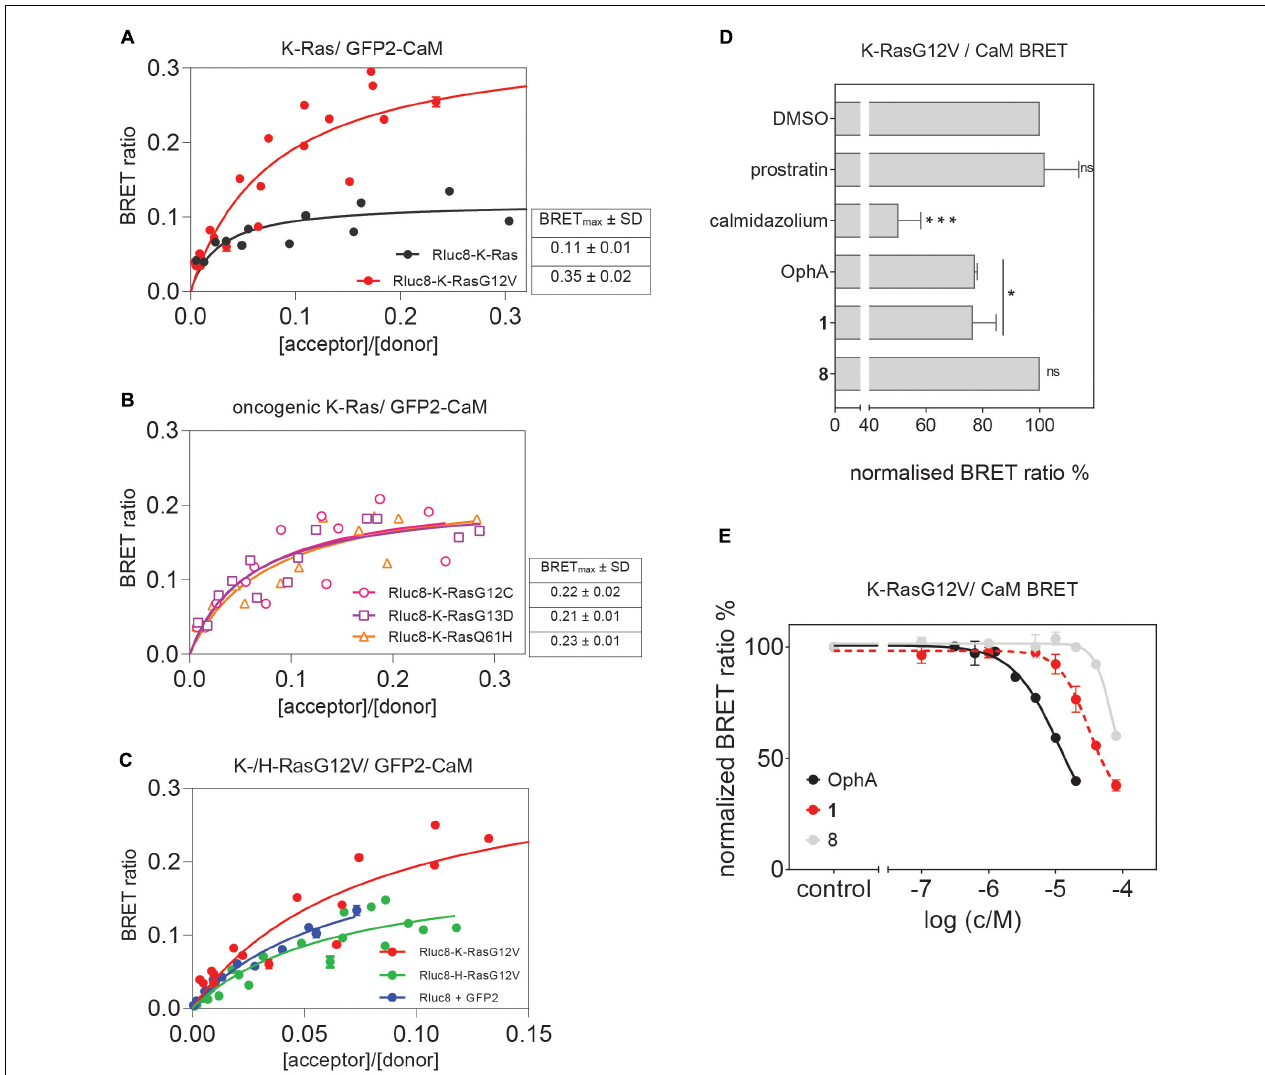
FIGURE 4 | Cellular K-RasG12V/CaM interaction BRET confirms on-target activity of compound 1 in cells. (A) BRET donor saturation titration curves between Rluc8-K-Ras or Rluc8-K-RasG12V and N-terminally GFP2-tagged CaM. (B) BRET donor saturation titration curves between the Rluc8-tagged K-Ras oncogenic mutants (K-RasG12C, K-RasG13D, and K-RasQ61H) with GFP2-CaM. The BRET max data represent mean values ± SD, n ≥ 2. (C) BRET donor saturation titration curves between Rluc8-K-RasG12V or Rluc8-H-RasG12V and GFP2-CaM. Plasmids expressing Rluc8 and GFP2 proteins alone were used as controls for non-specific interaction. (D) Compounds calmidazolium (20 µ M), prostratin (20 µ M), or OphA (5 µ M), as well as formyl aminobenzazulenone 1 (20 µ M) or non-formylated counterpart aminobenzazulenone 8 (20 µ M) were tested using the Rluc8-K-RasG12V/GFP2-CaM BRET reporter. The A/D plasmid ratio was 9/1. Data represent mean values ± SD, n ≥ 2. (E) Dose-response analysis of compound 1 and its non-formylated derivative 8 as compared to OphA using Rluc8-K-RasG12V/GFP2-CaM BRET signal. The A/D plasmid ratio was 9/1. Data represent mean values ± SD, n ≥ 2. The statistical significance levels are annotated as * p < 0.05; *** p < 0.001, or ns, not